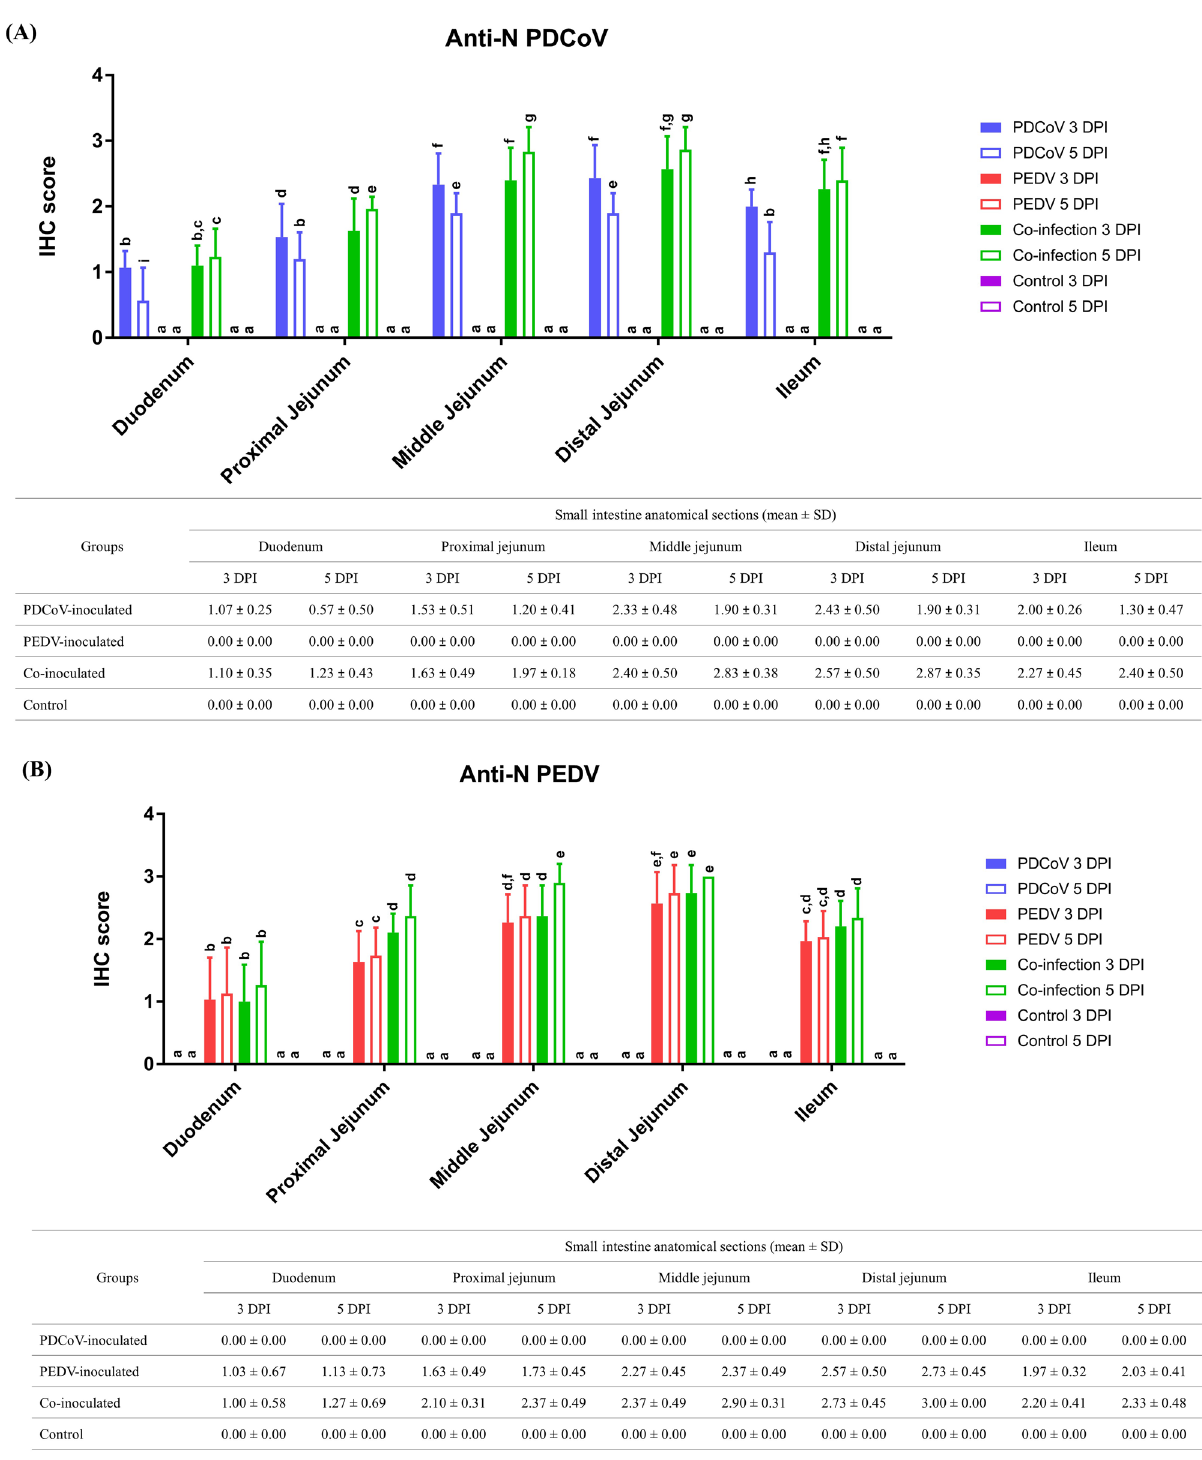
Figure 4. IHC scores of PDCoV ( A ) and PEDV ( B ) antigens in small intestinal enterocytes. Blue, red, green, and purple bars represent PDCoV-inoculated, PEDV-inoculated, co-inoculated, and control groups. Solid and open bars represent 3- and 5-days post-inoculation (dpi), respectively. Different lower-case letters indicate significant differences between each group, each dpi, and each anatomical section of the small intestine ( p < 0.05). Values of mean ± standard deviation (SD) of each group, and each dpi are presented in a table under the